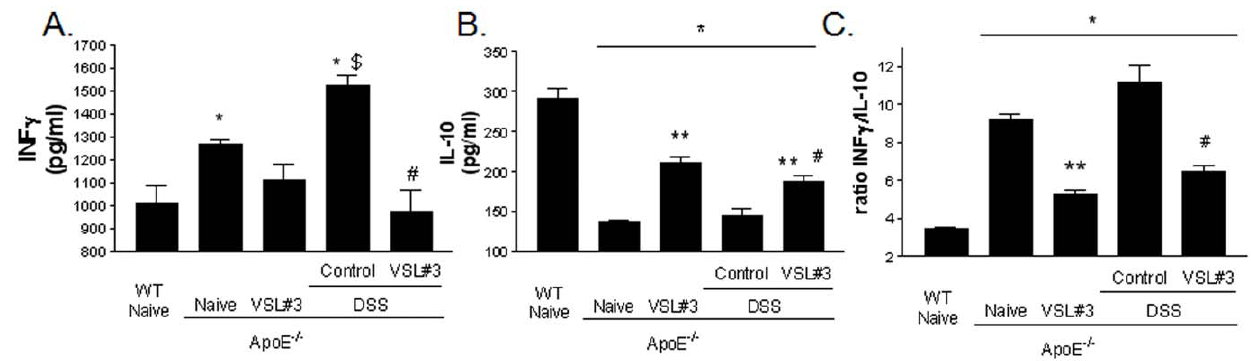
Figure 6. Effect of VSL # 3 administration on the induction of T-lymphocytes IL-10-producing cells in spleen in ApoE 2 / 2 mice. T- lymphocytes were isolated from spleens of mice and then stimulated with concanavalin A for 36 h in vitro. INF c and IL-10 in the supernatants were assayed by ELISA. The bar indicates mean 6 SE of 5 samples from 5 mice in each group. * p , 0.05 ApoE 2 / 2 experimental group versus naive wild type group; ** p , 0.05 ApoE 2 / 2 naı¨ve group versus ApoE 2 / 2 plus VSL # 3 group; $ p , 0.05 ApoE 2 / 2 naive group versus ApoE 2 / 2 plus DSS group;